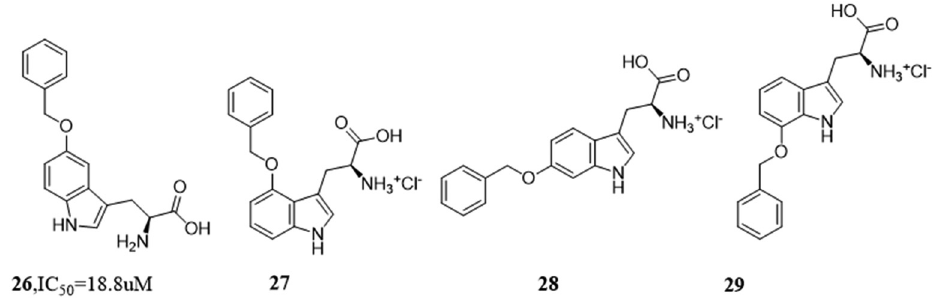
Figure 11: Chemical structures of compounds 26 – 29 .